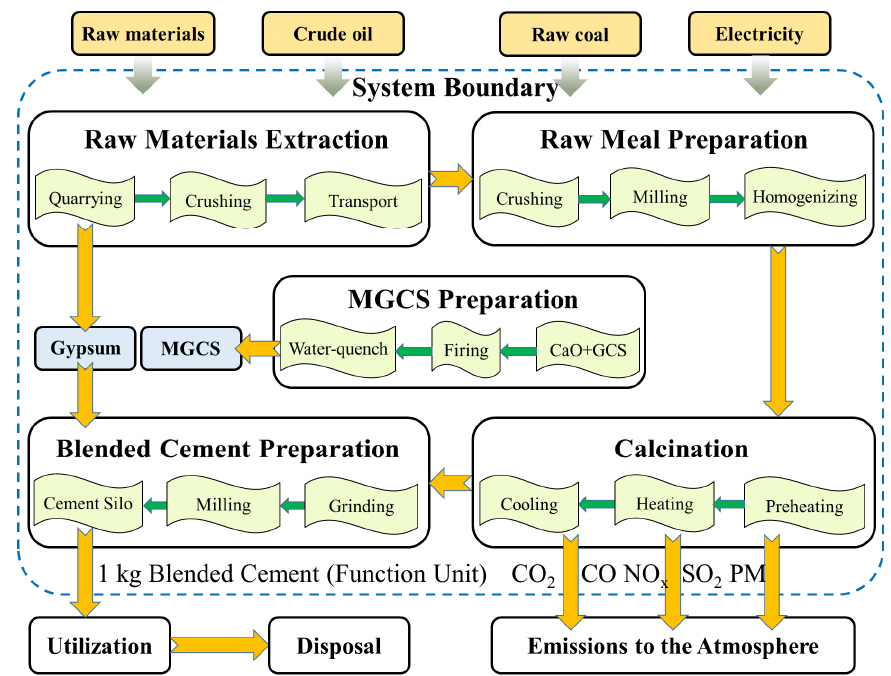
Figure 1. The process of blended cement production (System boundary).